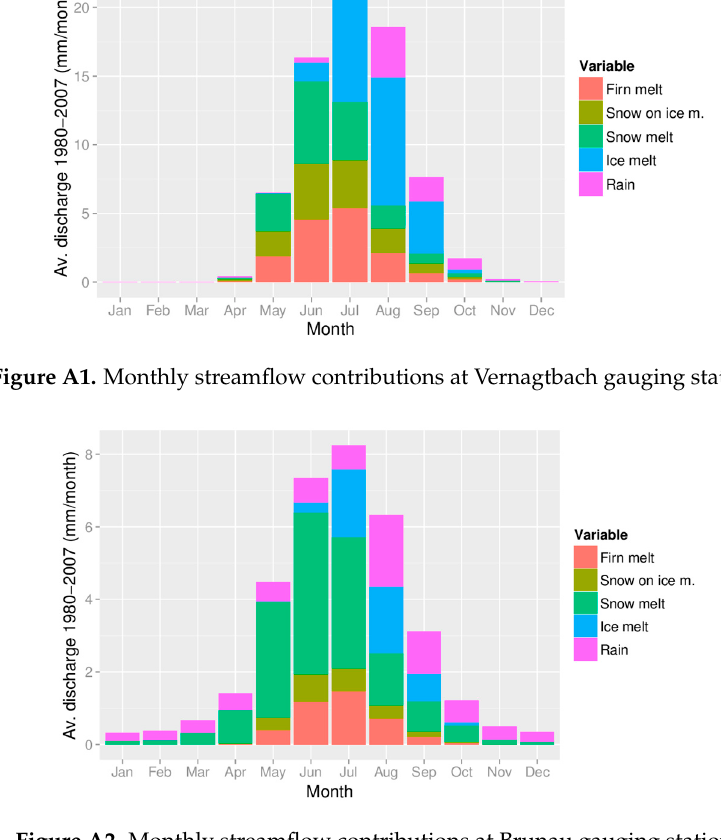
Figure A2. Monthly streamflow contributions at Brunau gauging station.